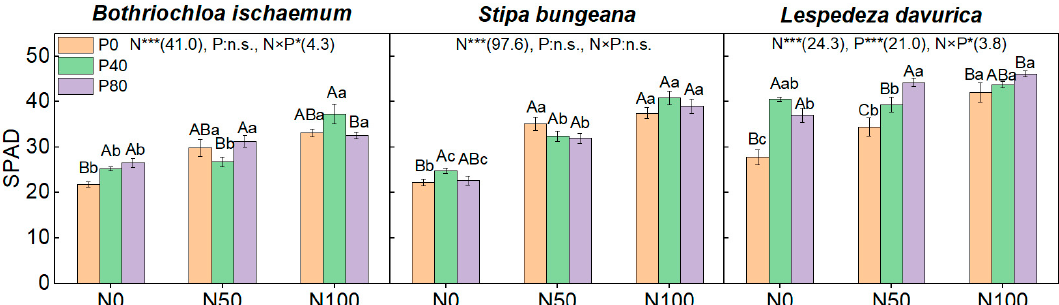
Figure 4. Leaf SPAD values of the three species under different N and P addition treatments. Different capital letters above the column indicate significant differences among P additions under each N addition rate, while different small letters indicate significant differences among N additions under each P addition rate. Numbers in parentheses are F -values, while ‘*’ and ‘***’ indicate p ≤ 0.05 and p ≤ 0.001, respectively. ‘n.s.’ indicates no significant difference.